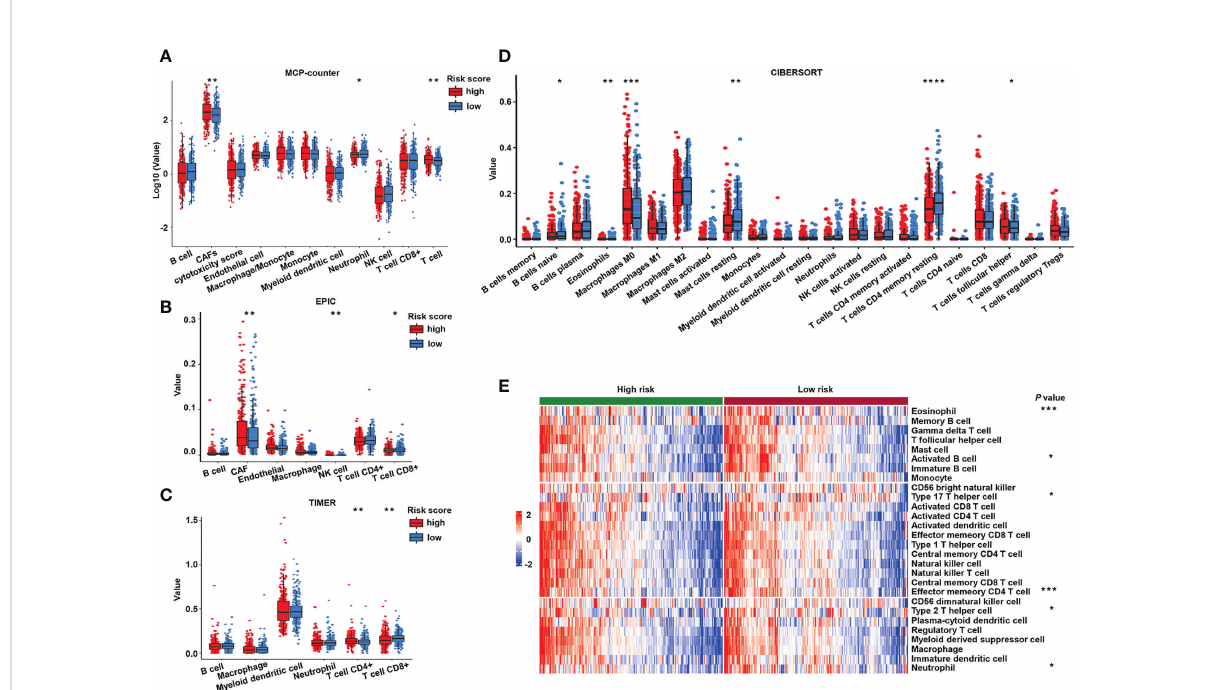
FIGURE 8 Immune cell in fi ltration of the different risk groups. Estimated immune cell in fi ltration value in different risk groups by MCP-counter (A) , EPIC (B) , TIMER (C) , and CIBERSORT (D) . (E) Heat map of prediction of immune cells in fi ltration in the high- and low-risk groups by GSVA. GSVA, gene set variation analysis. **** P < 0.0001; *** P < 0.001; ** P < 0.01; * P<